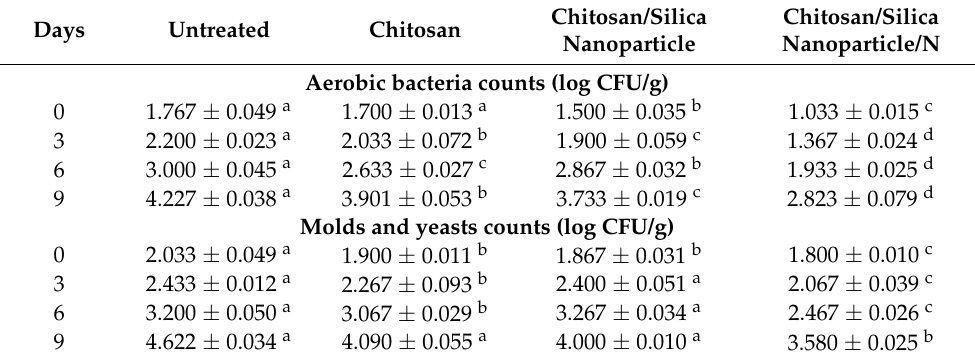
Table 2. Effect of coating films on microbial contamination analysis of blueberry fruits during storage.